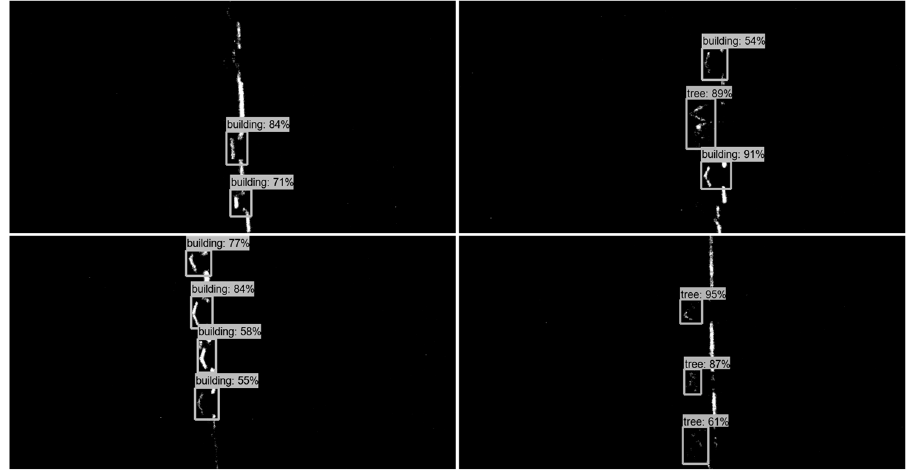
Table 4. Network performance comparison.